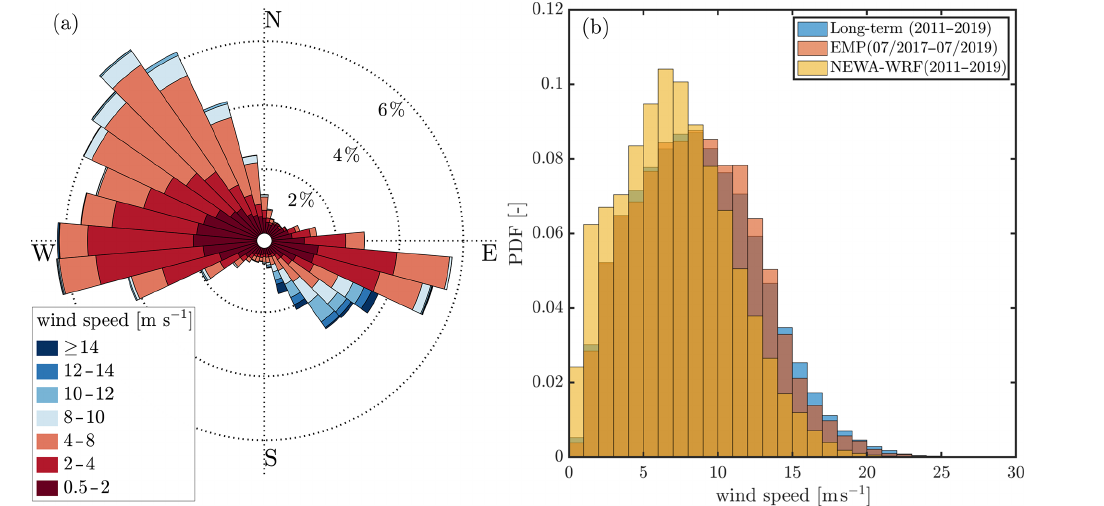
Figure 6. Panel (a) shows the wind rose of 10min wind speeds at the valley measured by M5 at 80ma.g.l. Panel (b) shows the wind speed distributions at 118ma.g.l. measured at MP5 during the reference period and EMP along with the modeled wind speeds from NEWA-WRF for the reference